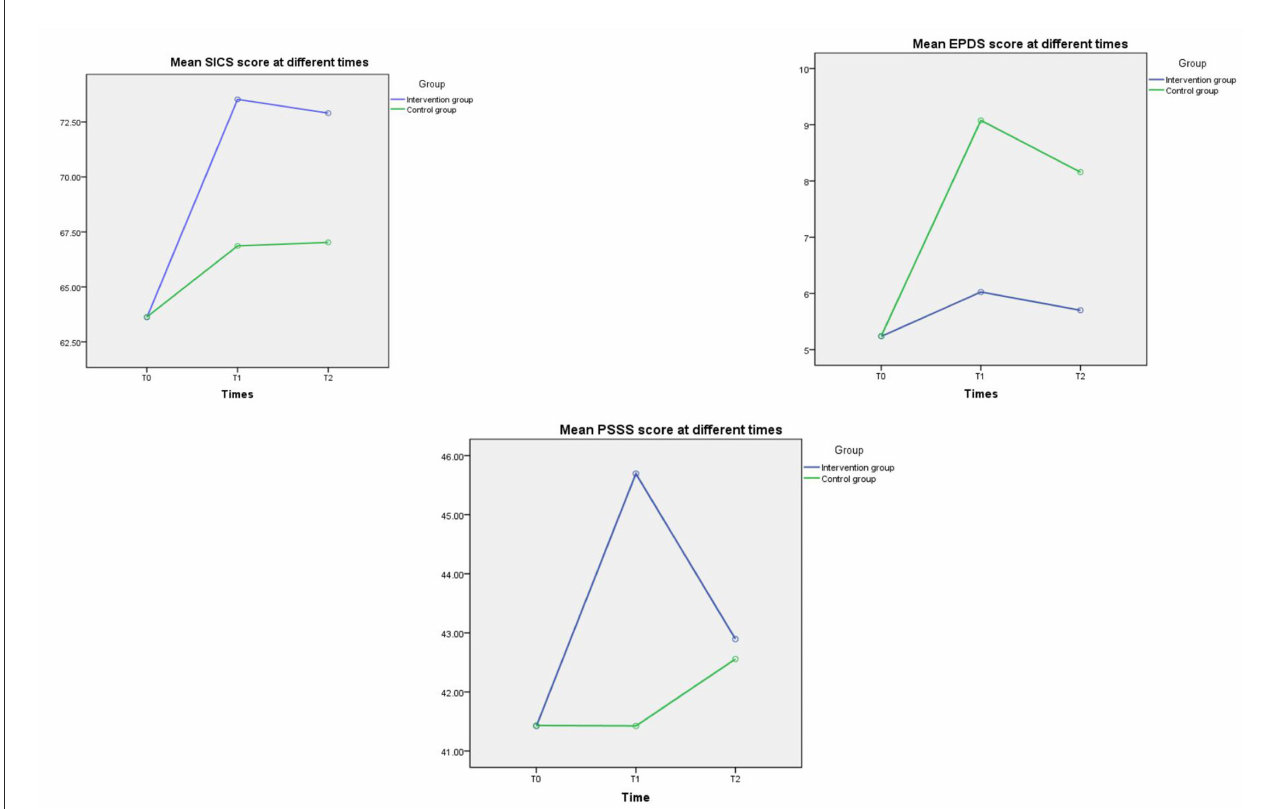
FIGURE3 The mean score change in SICS, EPDS and PSSS at T0, T1, and T2. SICS, the Self-efficacy in Infant Care Scale; EPDS, Edinburgh Postnatal Depression Scale; PSSS, Postnatal Social Support